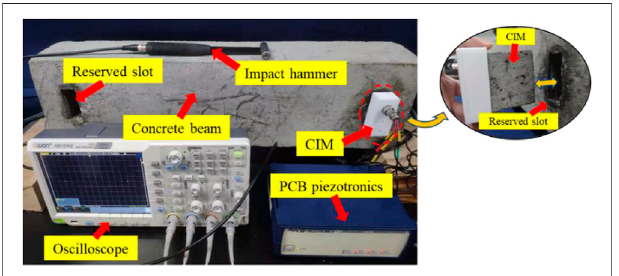
FIGURE 10 | Measurement method for the estimation of stress wave velocity.